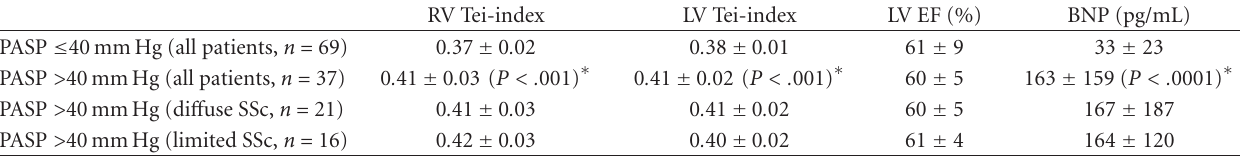
Table 4: Echocardiography-derived measurements of myocardial performance and BNP blood levels (mean ± SD) in SSc patients with normal or elevated PASP. RV